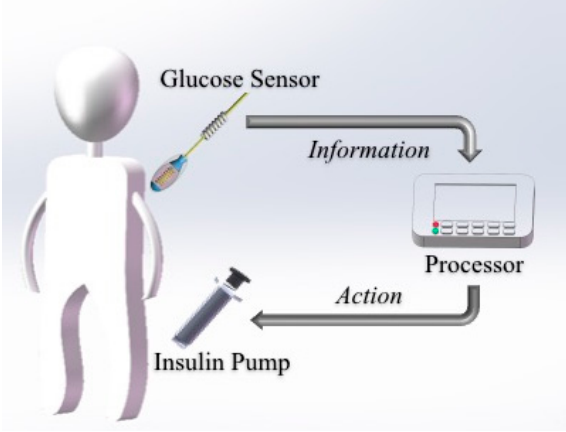
Figure 4. Illustration of closed-loop glycemic management system utilizing the ‘Sense and Act’ method for optimized insulin delivery.